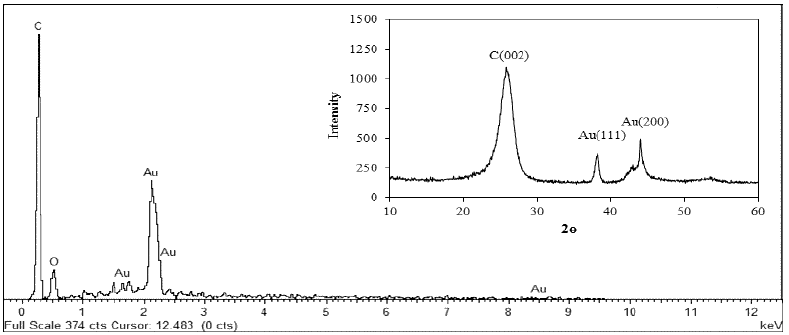
Figure 3. EDX Spectra of AuNPs/en-MWCNTs nanocomposites. Inset: XRD Spectra of the